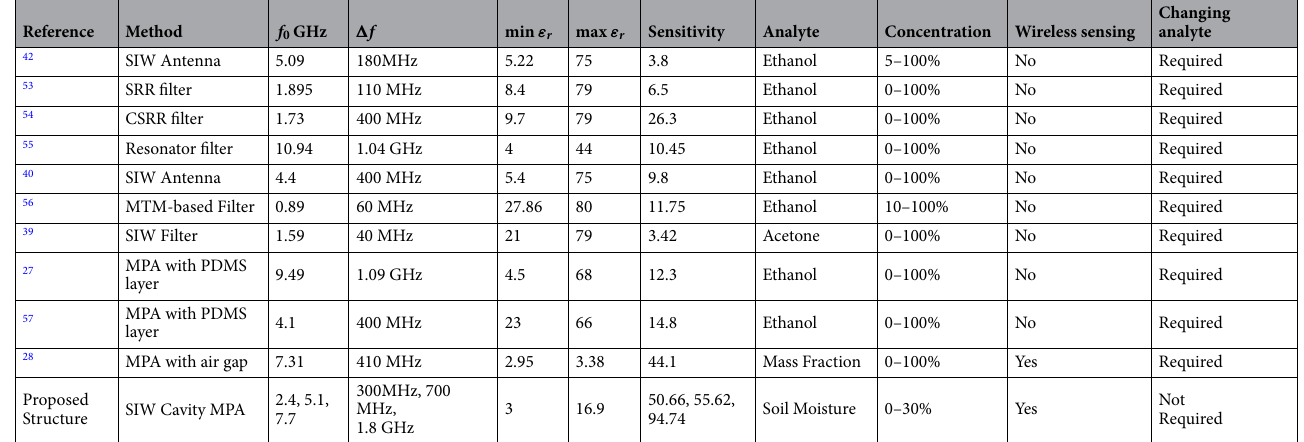
Table 4. Some reported MPAs for removing undesired signals applications.